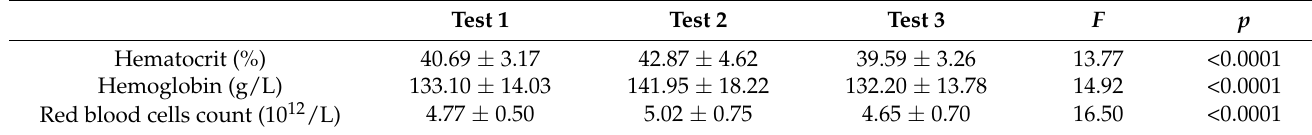
Table 1. Hematological results.